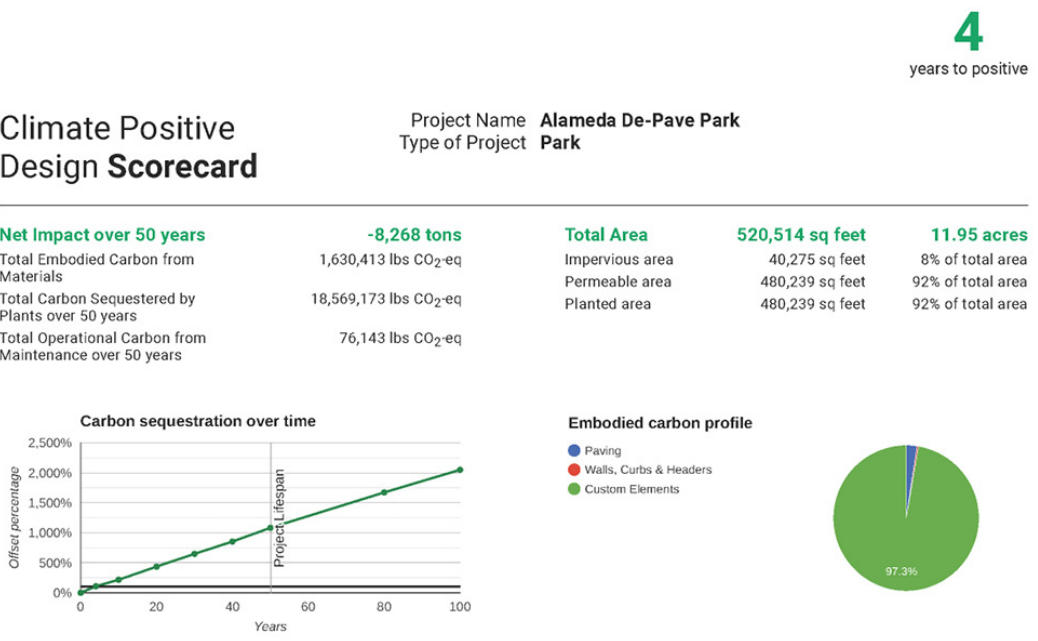
Figure 1. Example of a scorecard with the use of the Pathfinder tool, demonstrating the embodied and sequestered carbon over 50 years. Source: CMG Architects .